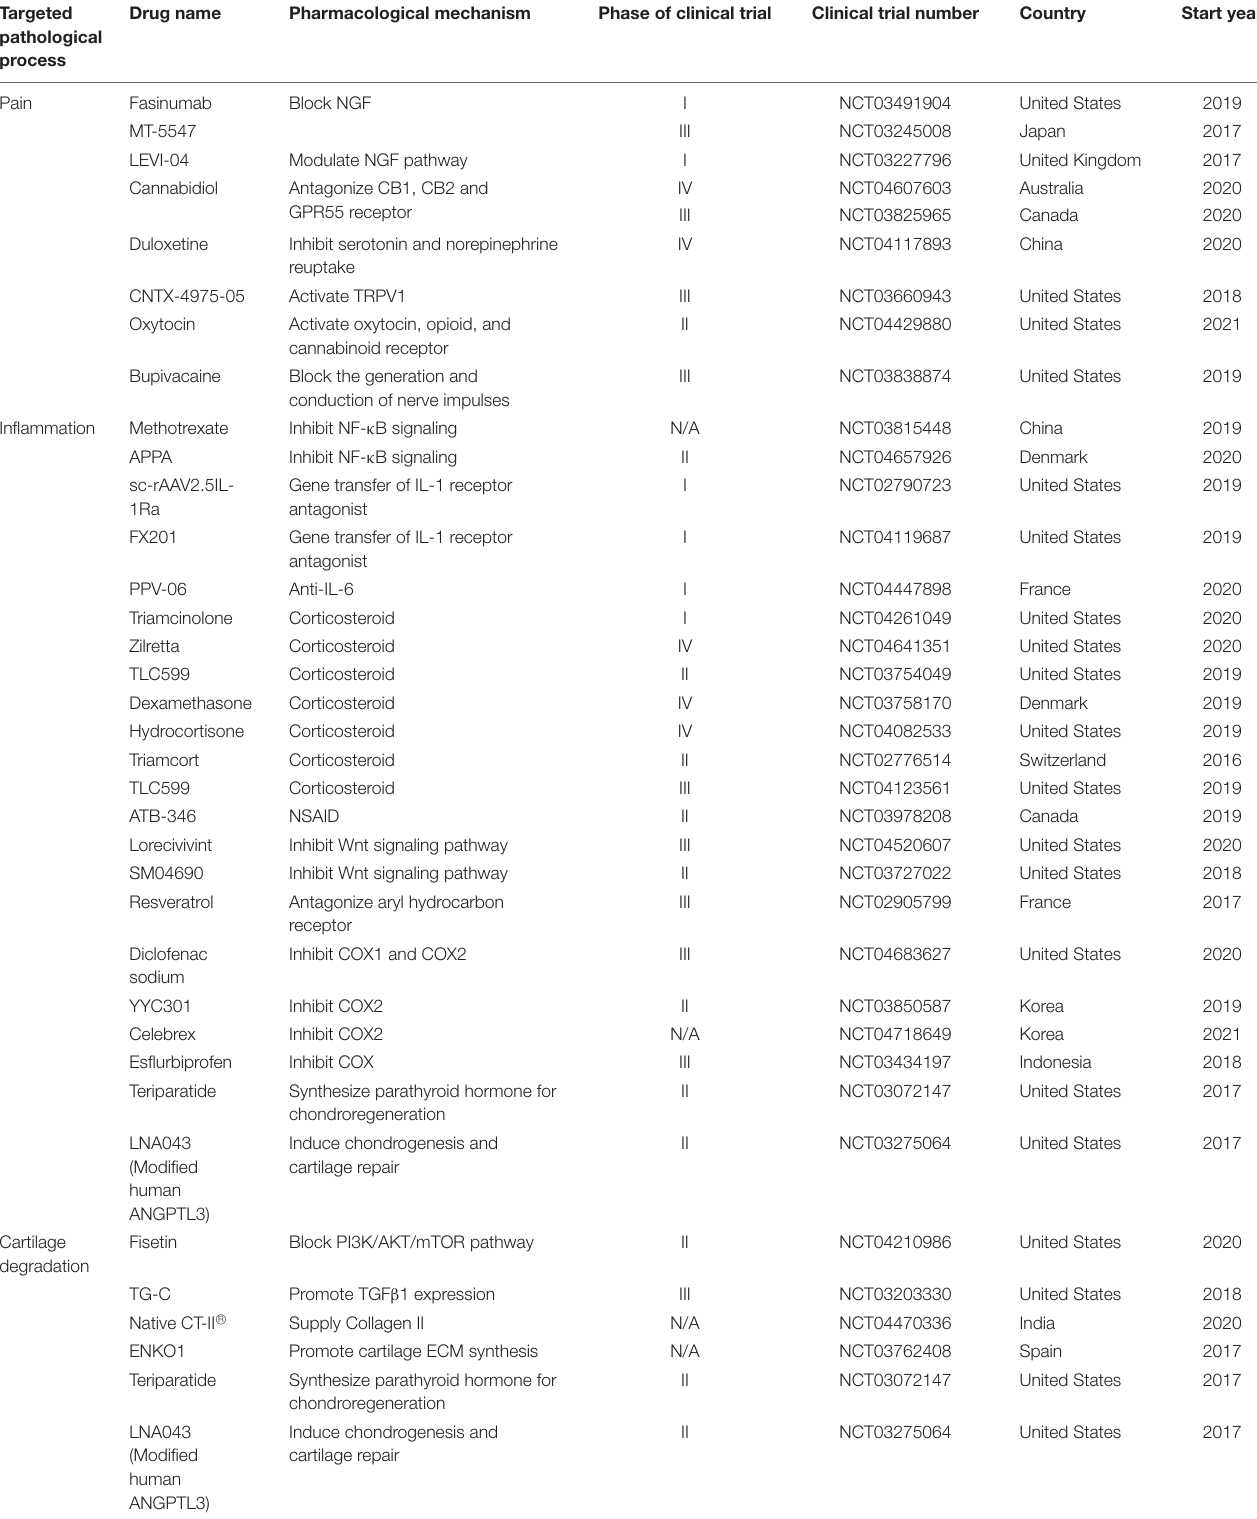
TABLE 1 | Ongoing clinical trials investigating the efficacy of drugs against